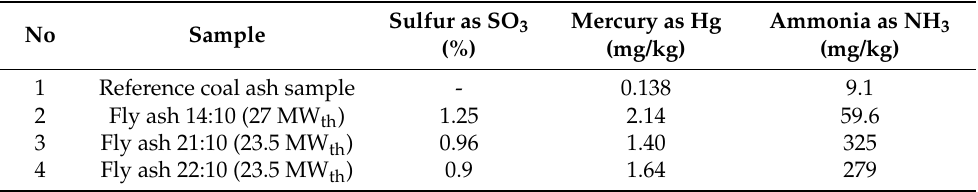
Table 3. Sulphur, mercury and ammonia content in fly